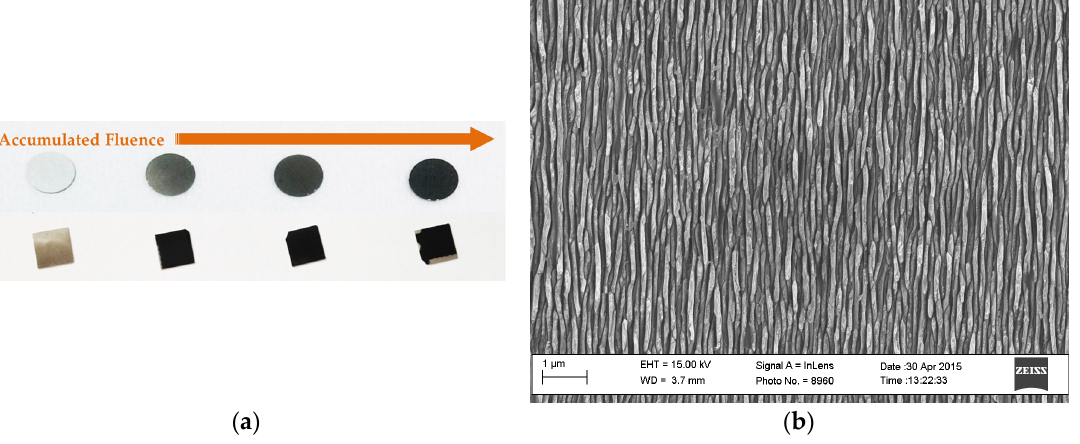
Figure 7. ( a ) Picture showing the increasing optical absorption capability of optical grade (upward) and thermal grade (downward and not in the same scale) diamond films as a function of increased laser accumulated fluence; ( b ) Microstructure of a typical black diamond film, treated at a laser wavelength of 800 nm, attributing it the peculiar optical and electronic properties [68] (CC BY 4.0).